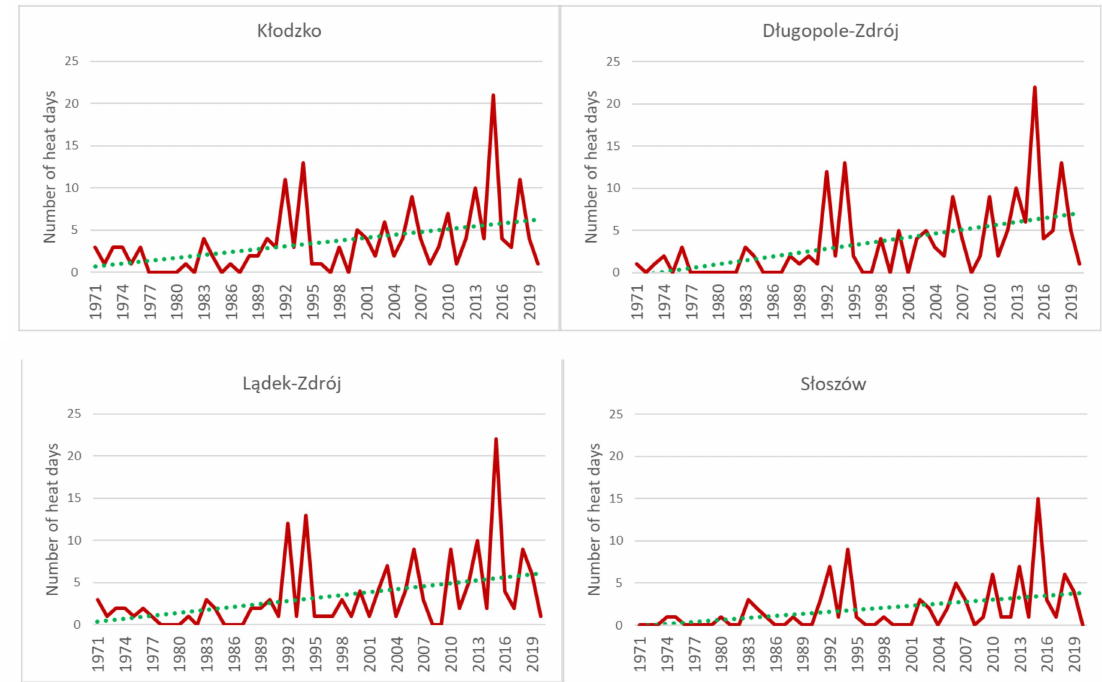
Figure 2. Annual number and linear trend of heat days (T max > 30 ◦ C) in Kłodzko Land in 1971–2020. Table 6. Rate of changes (per decade) in the number of heat days in July, August, and annually